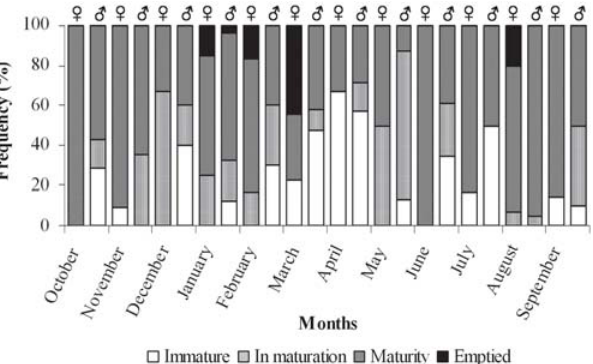
Fig. 8. Frequency of the reproductive stages found in each month to Hisonotus sp. in the Paulicéia